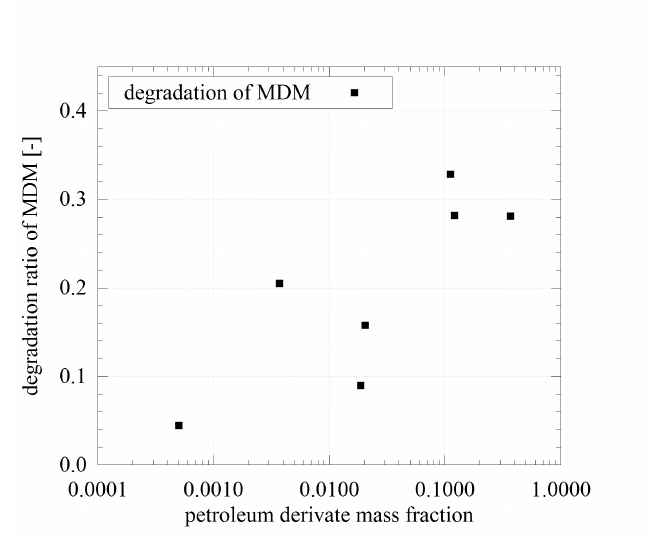
Figure 4. Degradation rate of MDM versus petrol derivate fraction in cycle